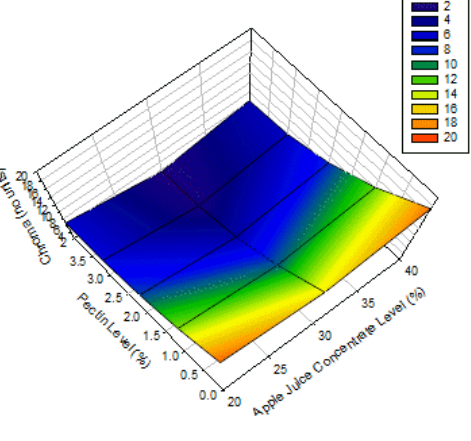
Figure 3. Surface plot for chroma of apple-blackcurrant fruit leather as affected by apple juice concentrate and pectin levels with a blackcurrant concentrate level of 6% (legend shows the range of values on the response